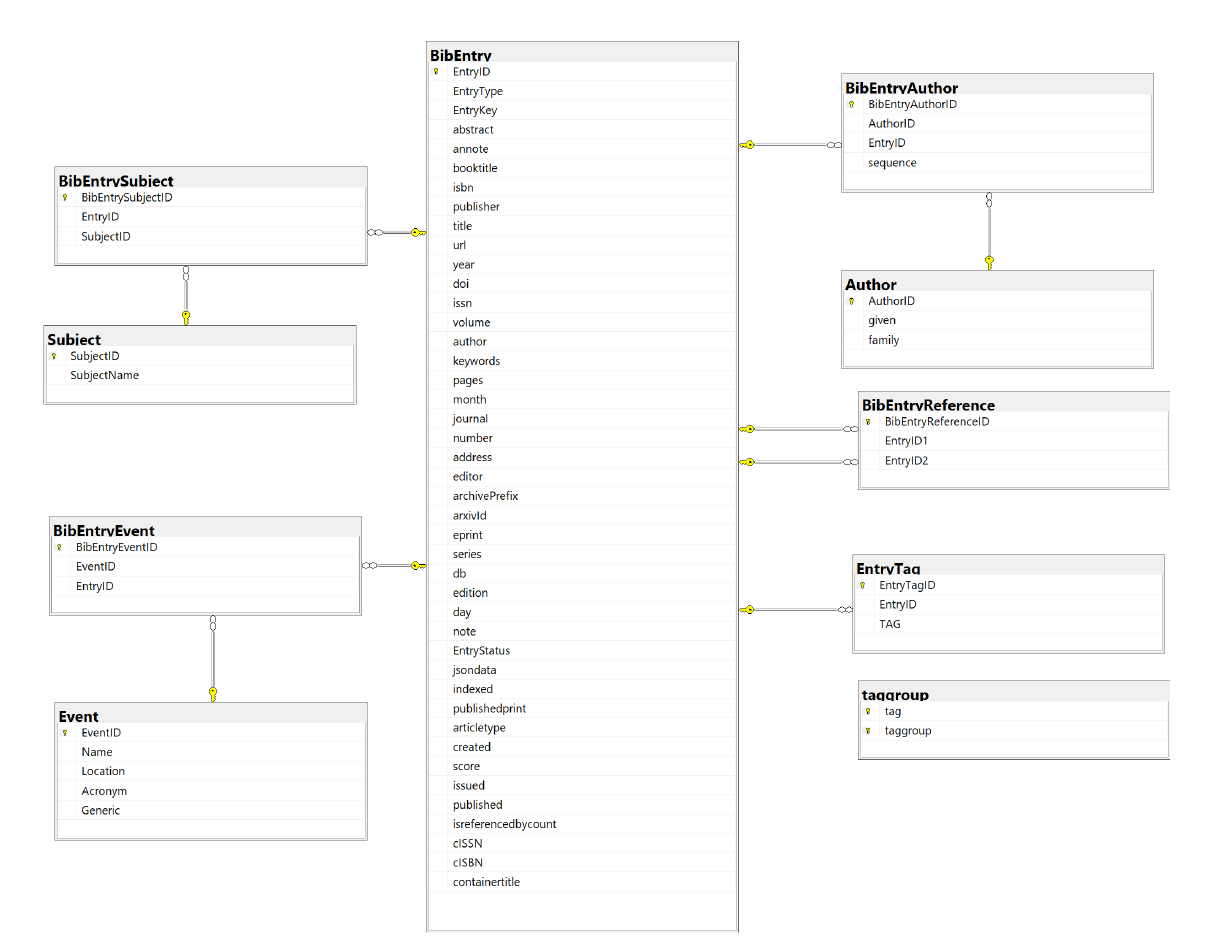
Figure 11. SQL tables